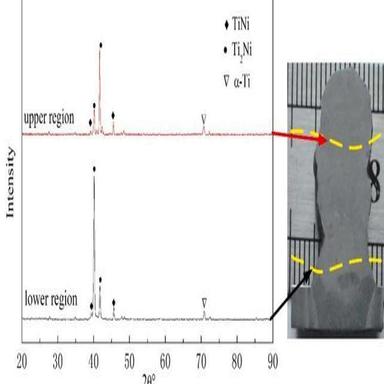
XRD patterns on deposition layers with different wire feeding speeds of Inconel 625.